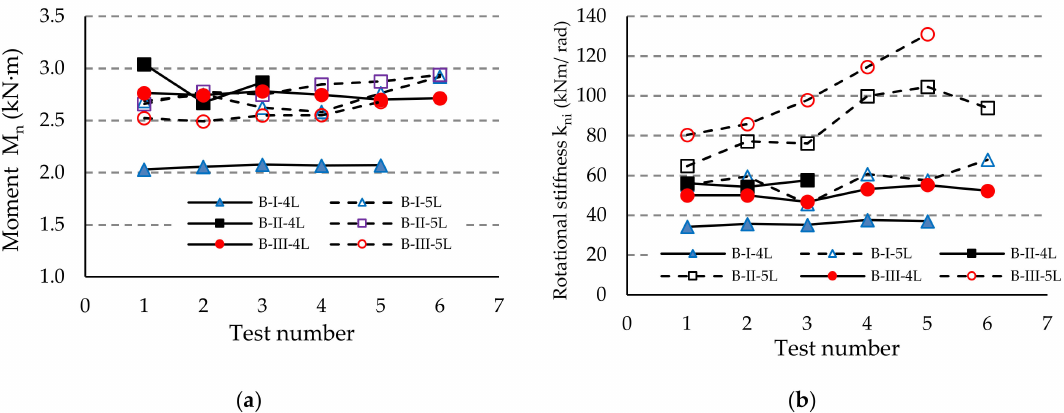
Figure 13. Comparison of the results obtained for the assemblies with the beam of type B concerning: